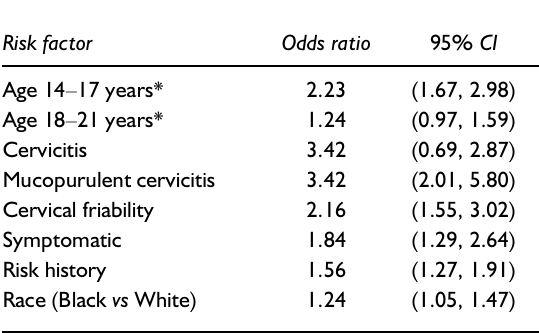
Table 2 Multivariate analysis of risk factors associated with C . trachomatis infection in women £ 24 years of